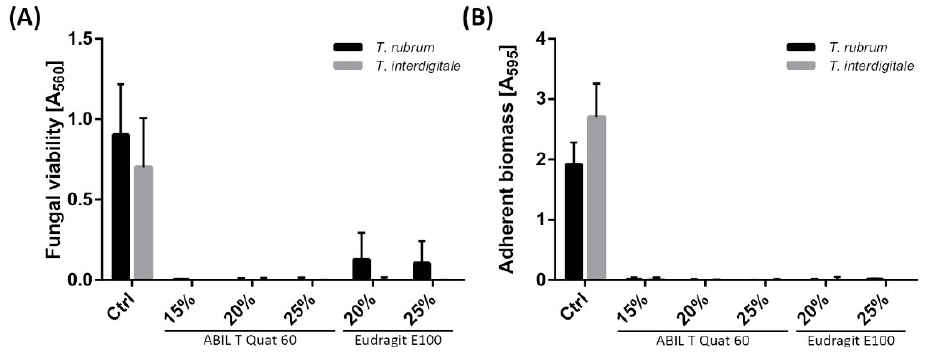
Figure 4. Inhibition of T. rubrum and T. interdigitale growth by ABIL and Eudragit based on fungal viability determined using phenol red ( A ) and adherence using crystal violet ( B ).